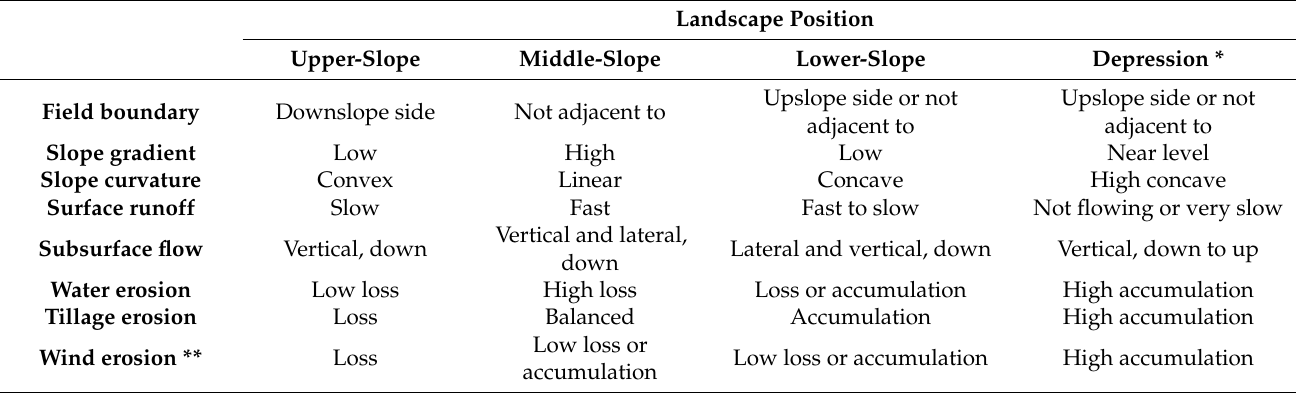
Table 1. Generalized topographic and hydrologic characters and erosion patterns for different landscape positions (revised based on [31]).